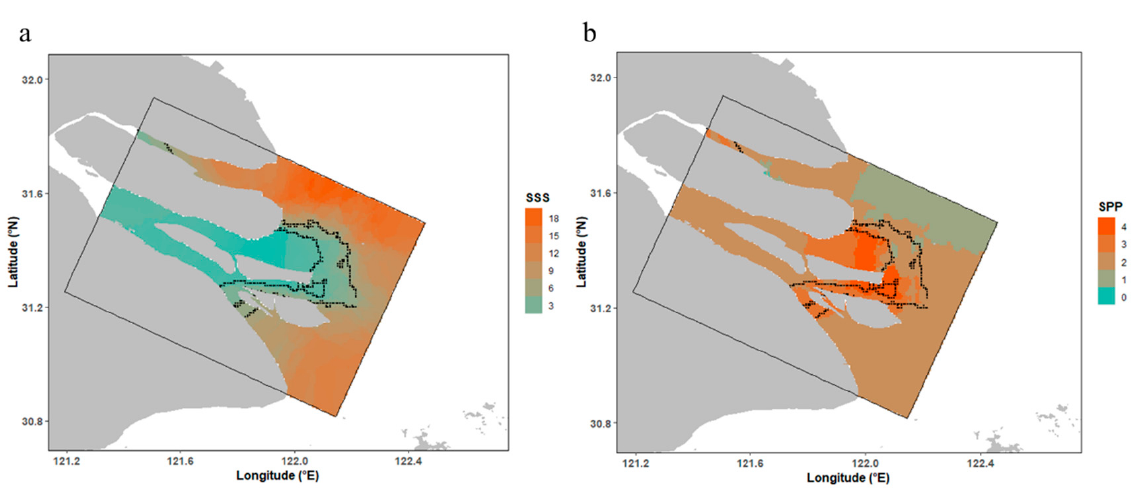
Figure 6. Spatial patterns of SSS ( a ) and the sum of predicted presences of the four species ( b ) considered in this study. Black-line region represents the confluence of salt and fresh waters. Map scale ranges from 0 (no species are predicted to be present) to 4 (all four species are predicted to be present). SSS, sea surface salinity; SPP, the sum of predicted presences.